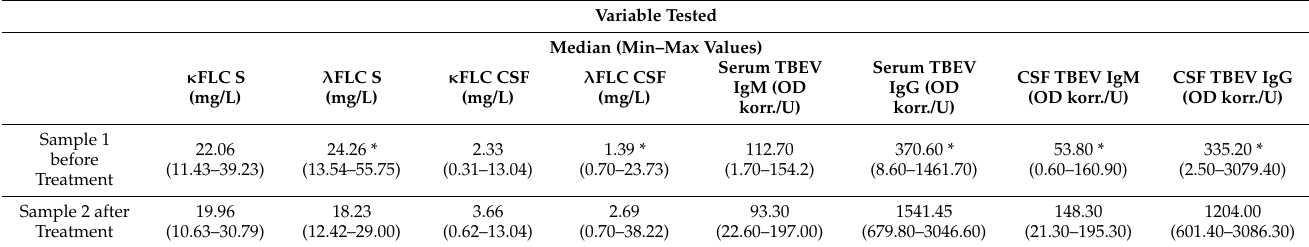
Table 3. Results of specific laboratory tests and calculated indexes in patients with tick-borne